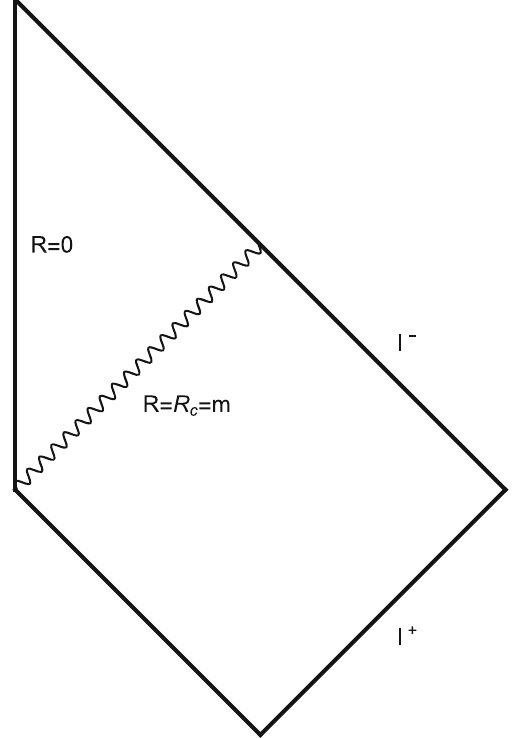
Fig. 8 Conformal diagram of the case m = R c when s = − 1. The diagram repeats itself in the vertical axis indefinitely. The wavy line represents the location of curvature